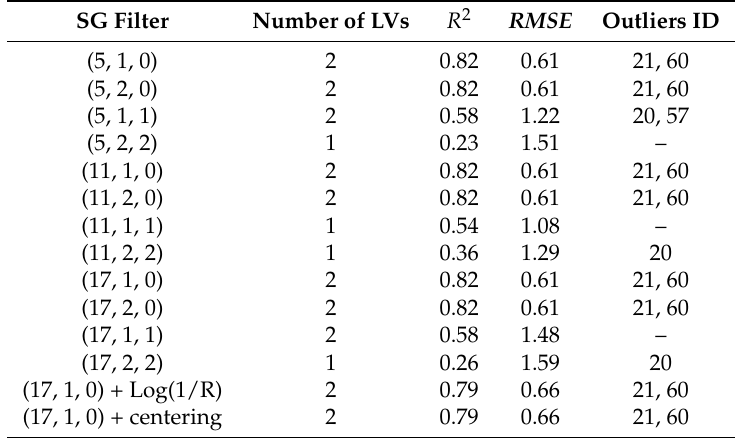
Table 2. PLSR performance for different Savitzky–Golay filter configurations applied to spectral data. The outlier ID column contains the index of the samples in the data set that were considered as